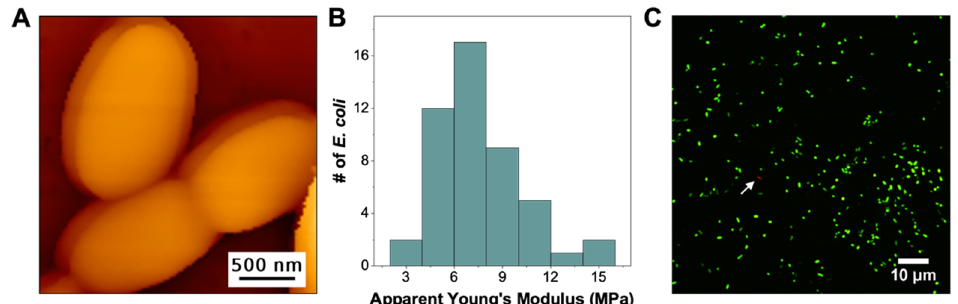
Figure 1. ( A ) Topography image of E. coli immobilized on the PEI-coated PC membrane. ( B ) Histogram of the average apparent Young’s Modulus of PC-PEI immobilized E. coli ( n = 48). ( C ) Fluorescence image of PEI-immobilized E. coli stained with SYTO 9 (green) and propidium iodide (red) to test for membrane integrity. White arrow points to a PI-stained bacterium.